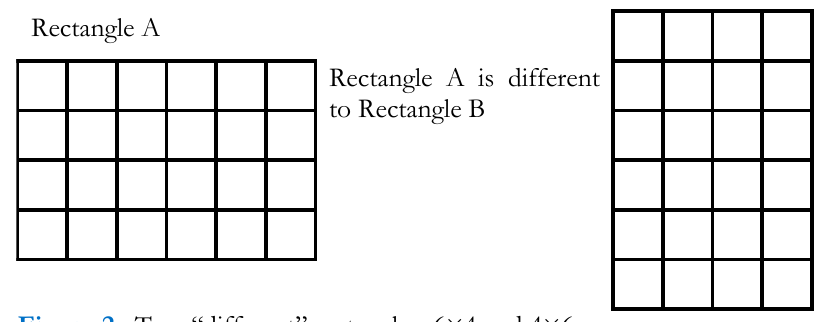
Figure 2. Two “different” rectangles, 6×4 and 4×6